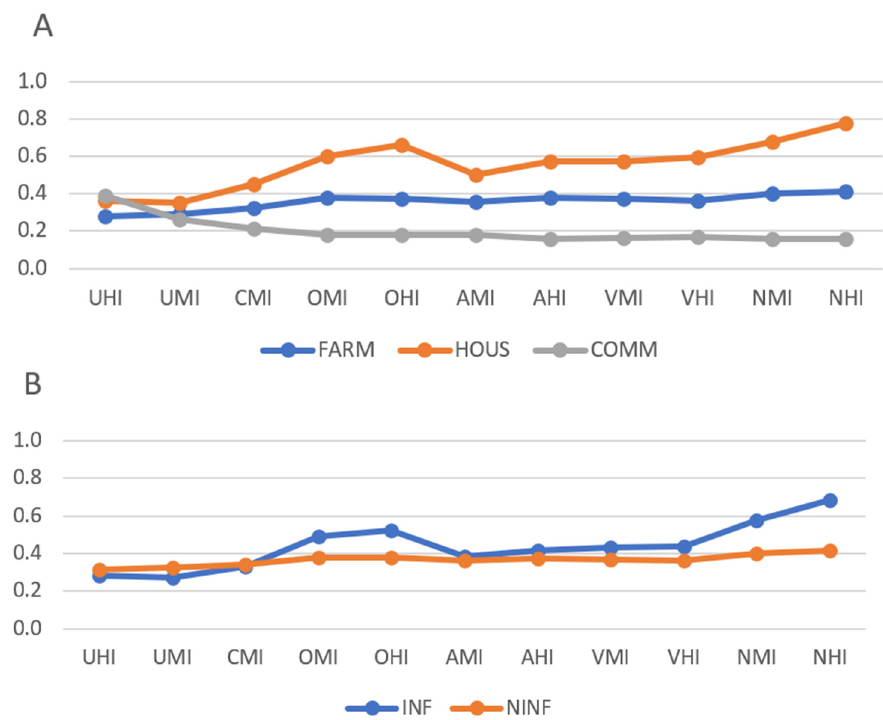
Figure 6. Average ratios between suitability calculated with supply ‐ based scaling and demand ‐ based scaling for each scenario and each landscape class (descriptions of landscape codes are reported in Table 1, scenario codes in Table 2). ( A ) economic perspective, ( B ) infrastructure